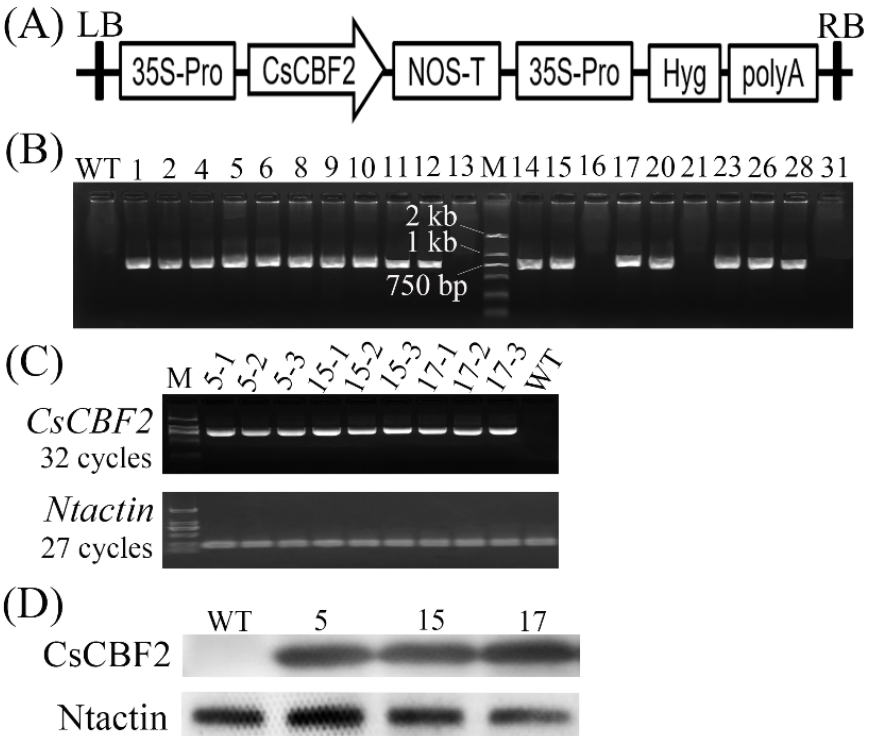
Figure 3. Identification and validation of CsCBF2 -overexpressing transgenic tobacco plants. ( A ) Constructs used to overexpress CsCBF2 in tobacco. 35S-Pro, 35S cauliflower mosaic virus 35 S promoter; NOS-T, 3 (cid:48) terminator region of the nopaline synthase gene; Hyg, hygromycin phosphotransferase-coding gene; polyA, cauliflower mosaic virus polyA signal; RB, right border; LB, left border. ( B ) PCR analysis of CsCBF2 open reading frame (ORF) sequence in T0 transgenic lines. ( C ) RT-PCR identification of CsCBF2 gene transcript in the T2 transgenic plants from three different T0 transgenic lines L5, L15 and L17. The tobacco housekeeping gene Ntactin was used as equal loading control. M: DNA marker. WT, wild type tobacco plant. ( D ) Western blot analysis of CsCBF2 protein expression in T2 transformants L5, L15, and L17 using the antibody against CsCBF2. Expression of Ntactin in T2 transformants L5, L15, and L17 was detected by Ntactin antibody and used as equal loading control of the total protein. WT, wild type tobacco